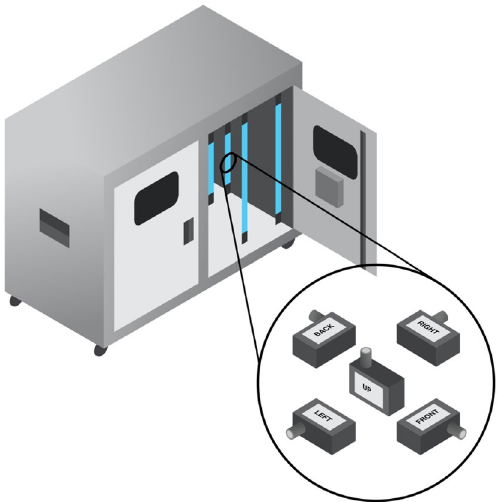
Figure 4. Orientation of spectroradiometer for irradiance measurements.